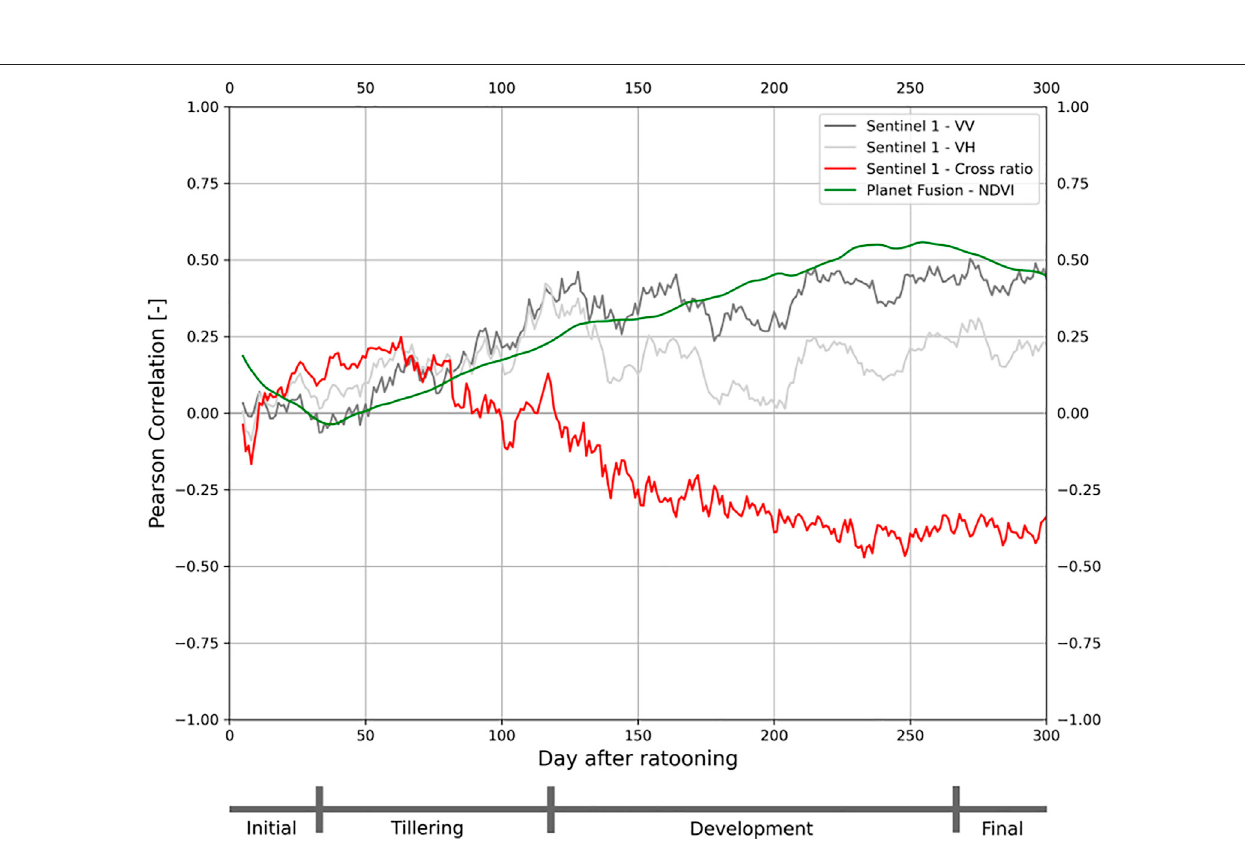
Frontiers in Remote Sensing |